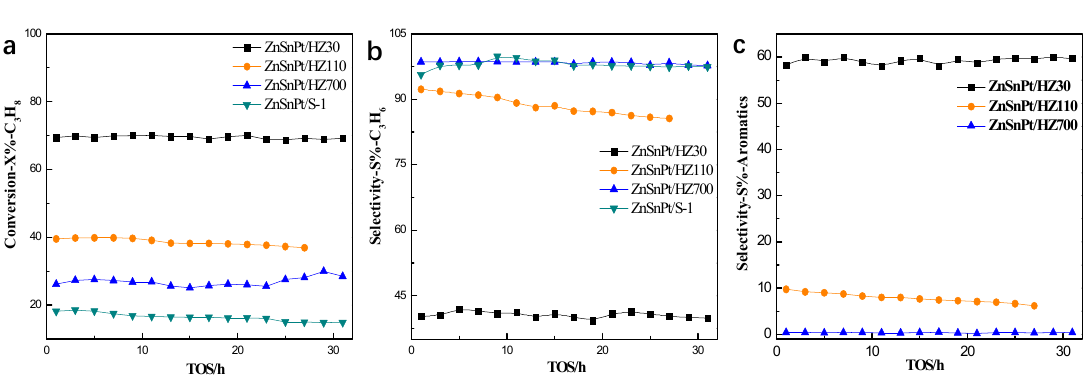
Figure 8. Stability test on ZnSnPt/MFI catalyst with different SiO 2 /Al 2 O 3 ratios. T = 610 °C, atmospheric pressure, GHSV = 1800 h -1 . ( a ) The conversion of propane; ( b ) the selectivity of C 3 H 6 ; ( c ) the selectivity of aromatics.